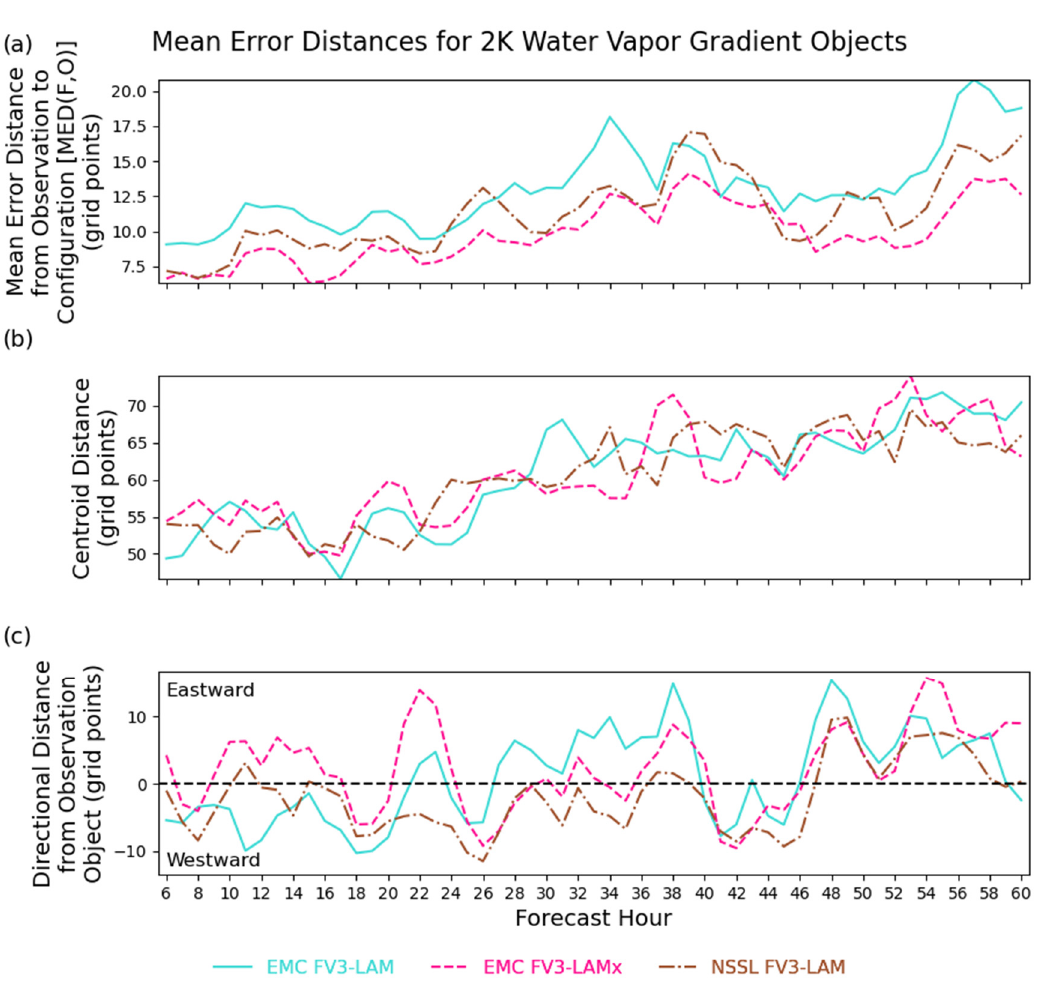
Figure 9. Time series of: ( a ) mean error distance (MED), ( b ) differences in centroid distance, and ( c ) zonal displacement errors between matching observation and forecast water vapor gradient objects associated with upper-level jet streams and troughs.